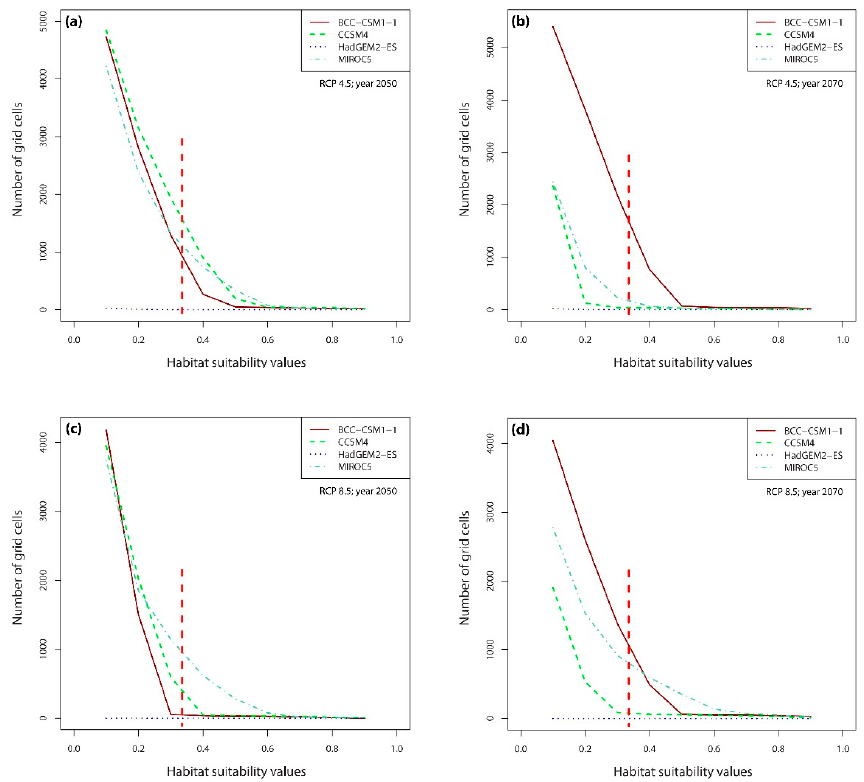
Figure 8. The number of grid cells in Nepal with particular habitat suitability values predicted for 2050 according to RCP4.5 ( a ) and RCP8.5 ( c ) and 2070 according to RCP4.5 ( b ) and RCP8.5 ( d ), based on four climate change models (see inset). The dashed vertical red line is the lowest presence threshold (LPT = 0.335). Table 2. Change in the coverage (km 2 ) of suitable niches of D. hatagirea in response to various climate change scenarios.